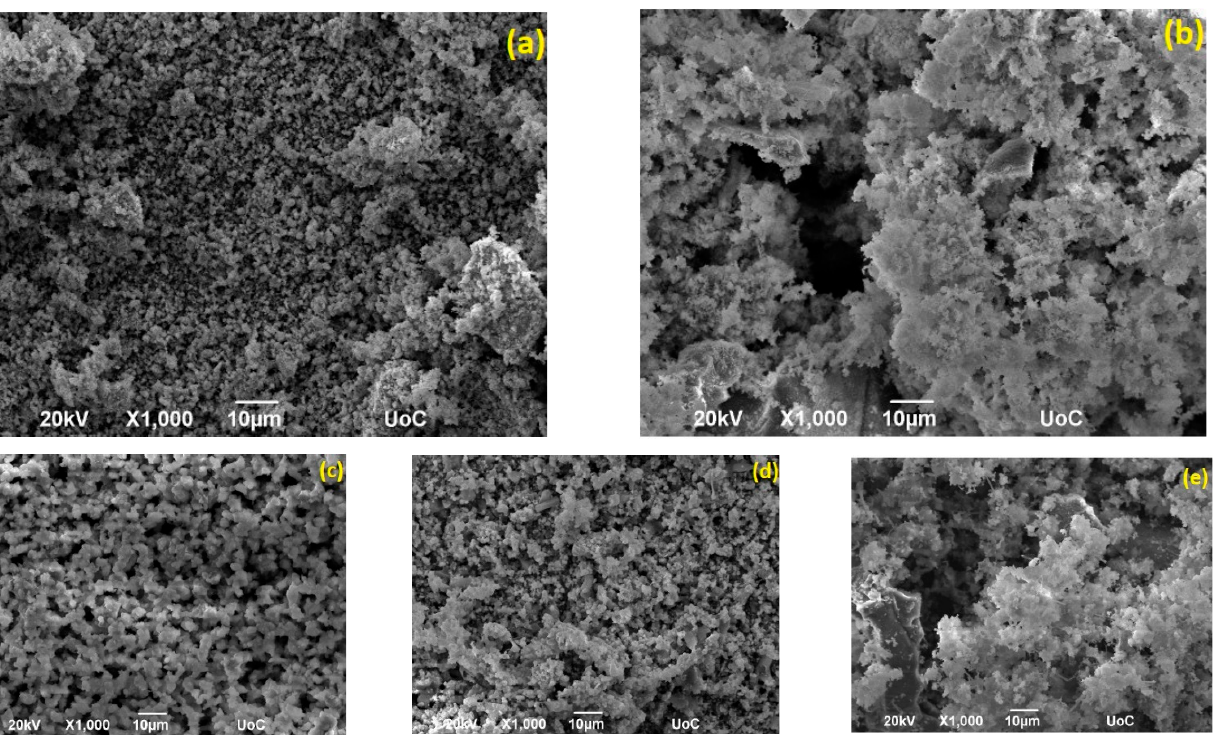
Figure 2. SEM images of the as-prepared samples: ( a ) Ni/CeO 2 ; ( b ) Ni/Al 2 O 3 ; ( c ) MS ( d ) MS-Ni/CeO 2; and ( e ) MS-Ni/Al 2 O 3 .